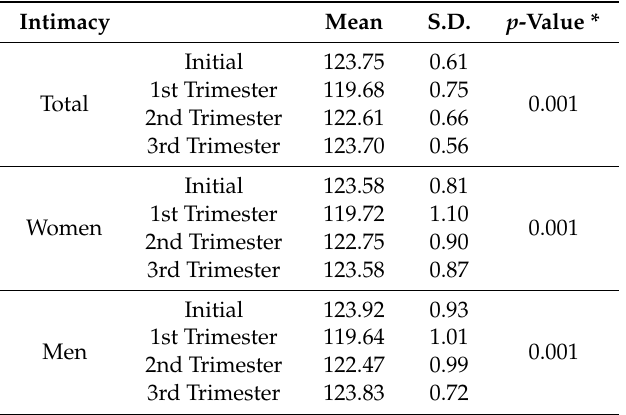
Table 9. Initial and final intimacy means for each